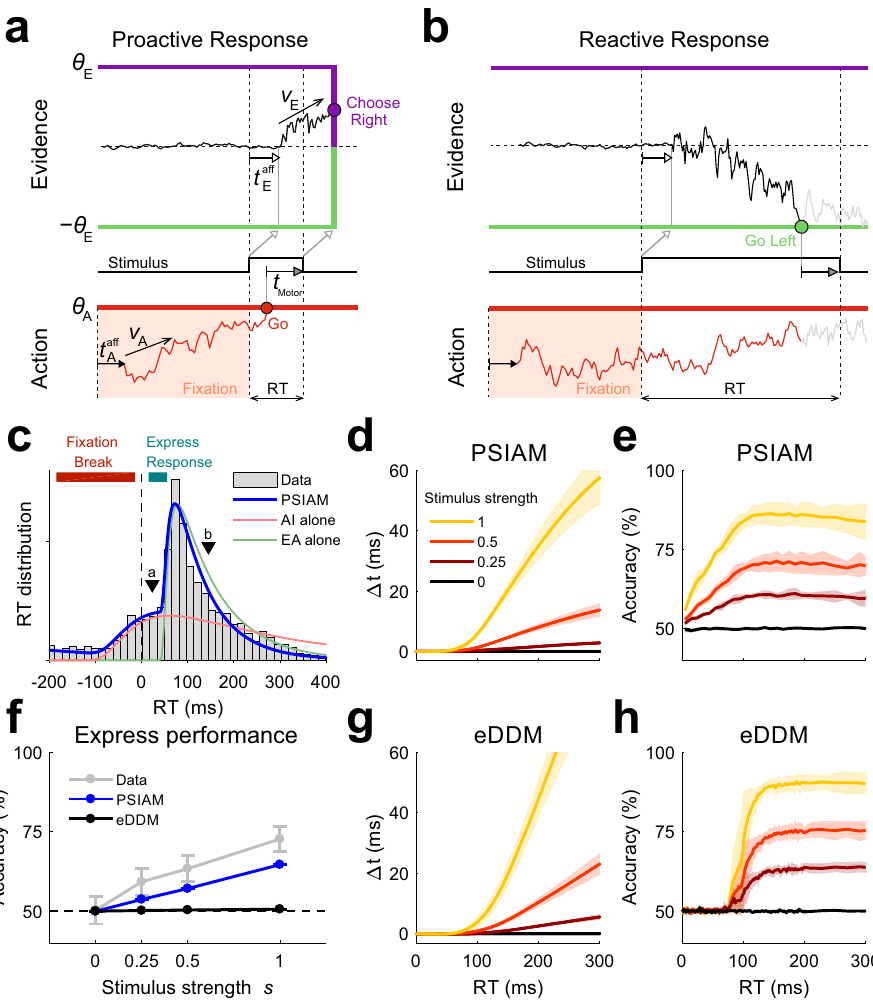
Fig. 3 Parallel Sensory Integration and Action model. a Example proactive response generated by the PSIAM. The action initiation process (AI, red trace) starts ramping up with afferent latency t A aff after the fi xation onset, with mean drift ν A , until it hits the Go bound θ A . The evidence accumulation process (EA, black trace) starts in response to the stimulus onset and after an afferent, sensory latency t E aff , with a stimulus-dependent mean drift ν E , and symmetric decision bounds ± θ E . RT is determined by the fi rst of the AI and EA processes reaching a bound. Here, AI reaches the Go bound fi rst, triggering a proactive response after a motor latency t motor . The stimulus is stopped at the response time (middle scheme). The choice is then determined by the fi nal sign of the EA process, after the full stimulus has been integrated. This read-out is illustrated by an instantaneous collapse of the decision bounds. b Example reactive response, where the EA process reaches a decision bound fi rst, setting both RT and choice; the AI process plays no role. c RT distribution for an example rat (gray bars; rat #12) and model fi t (blue line) for maximum stimulus strength s = 1. The distributions of proactive (red) and reactive (green) RTs generated by the AI and EA processes working in isolation are also shown. Triangles correspond to example responses shown in panels a - b . d Simulated time delay curves, generated from the PSIAM fi t to RTs for each animal, averaged across rats (Group 1, n = 10). Shaded areas: s.e.m. e Simulated tachometric curves, predicted from fi tting the PSIAM to each animal RTs, averaged across rats. RT bin width: 10 ms; shaded areas: s.e.m. f Accuracy on express response trials with RTs shorter than 50 ms as a function of stimulus strength s (gray), and for model predictions from the PSIAM (blue) and the extended DDM (black), both fi tted to individual rat RTs. Dots show average across rats. Error bars: s.e.m. g , h Same as in panels d , e for the eDDM. Lines: median across rats. Shaded areas: median absolute deviation. Source data are provided as a Source data fi